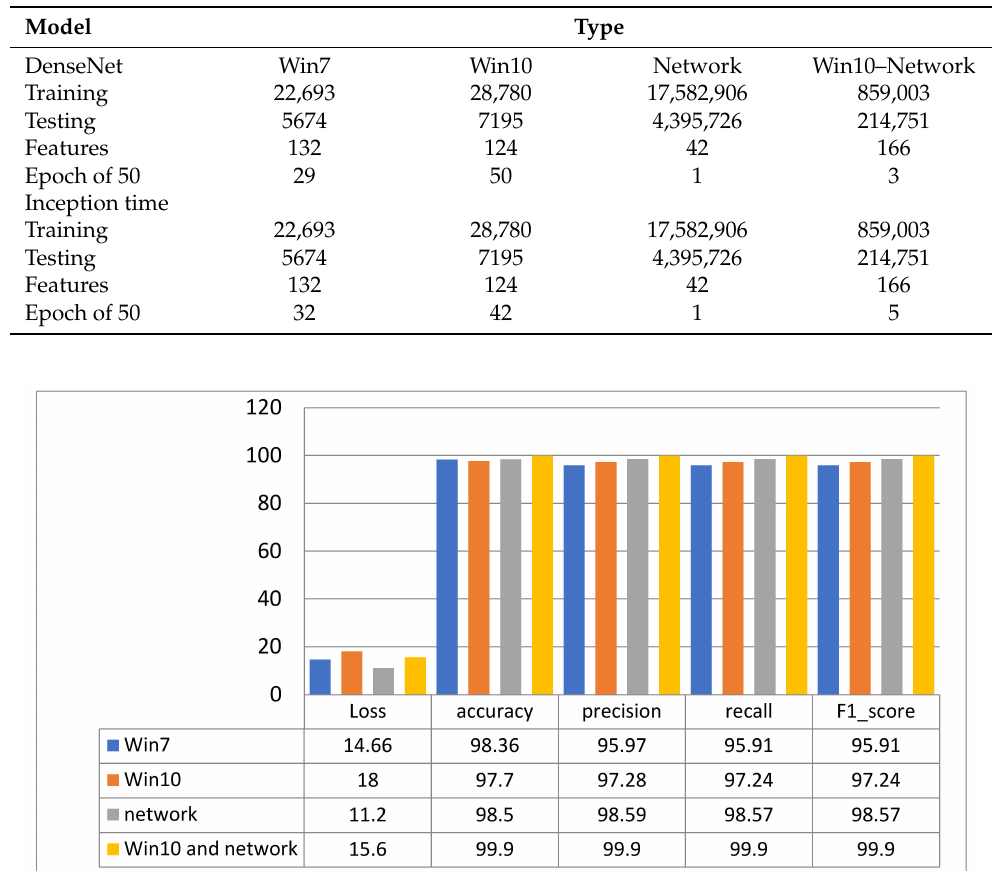
Figure 5. The results of the DenseNet model of the